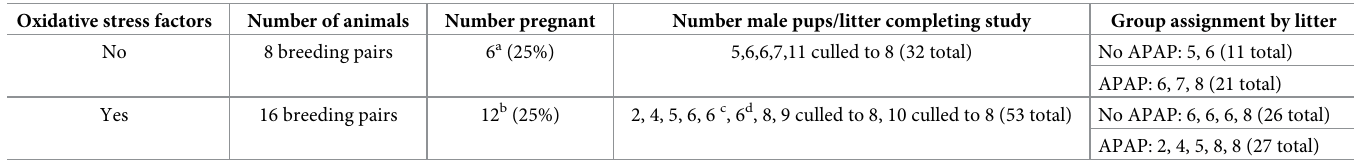
Table 1. Animals and group